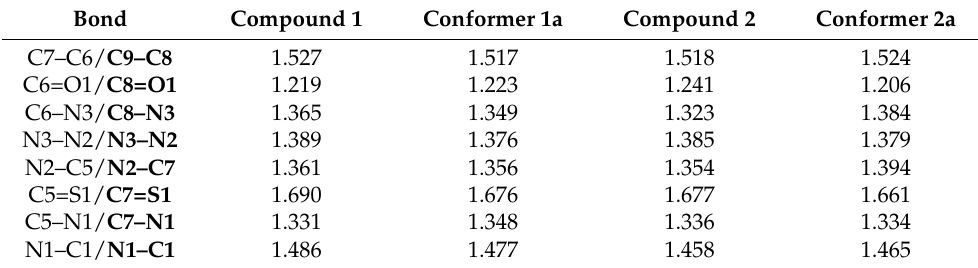
Table 2. Selected bond lengths in 1 and 2 . The bonds in bold corresponds to structure 2